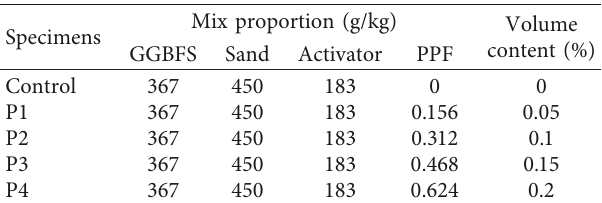
Figure 1: PPF with length 9mm. (a): Shape and dimension of PPF. (b): SEM picture of a single PPF. Table 3: The mix proportions of the AAS mortars.